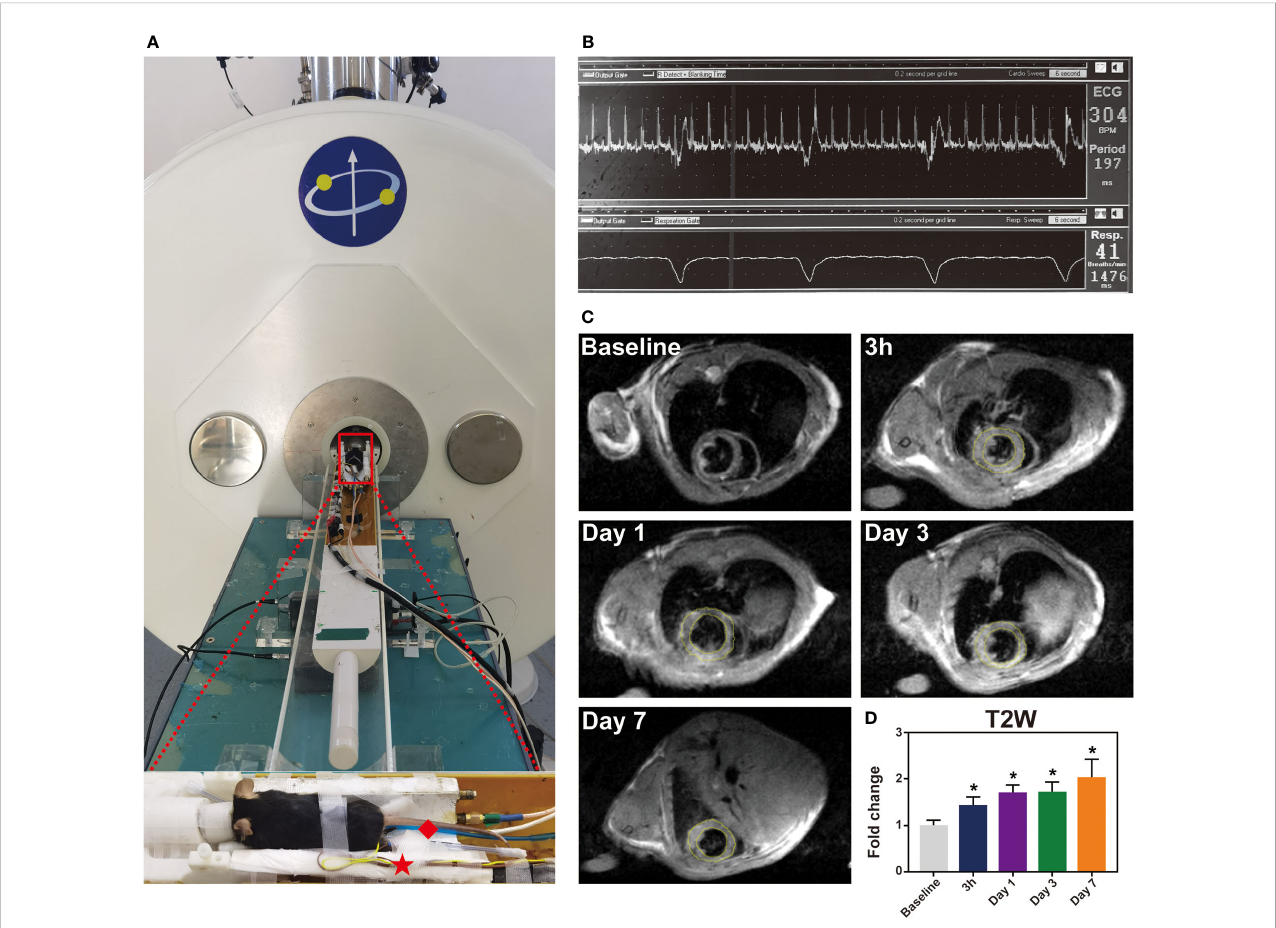
FIGURE 2 The immune response induced by IR injury at the fi rst week. Representative images of histological changes in the ischemic myocardium. (A) , for each time point, images are shown of staining with H&E (Bar=1mm, 50 m m). (B) , macrophages in mice post-IR were evaluated by CD68 staining (Bar=50 m m). (C-F) , plasma levels of IL-1 b (C) , TNF- a (D) , Arg-1 (E) and TGF- b (F) were also determined by ELISA (n = 3-5). *p < 0.05 VS.